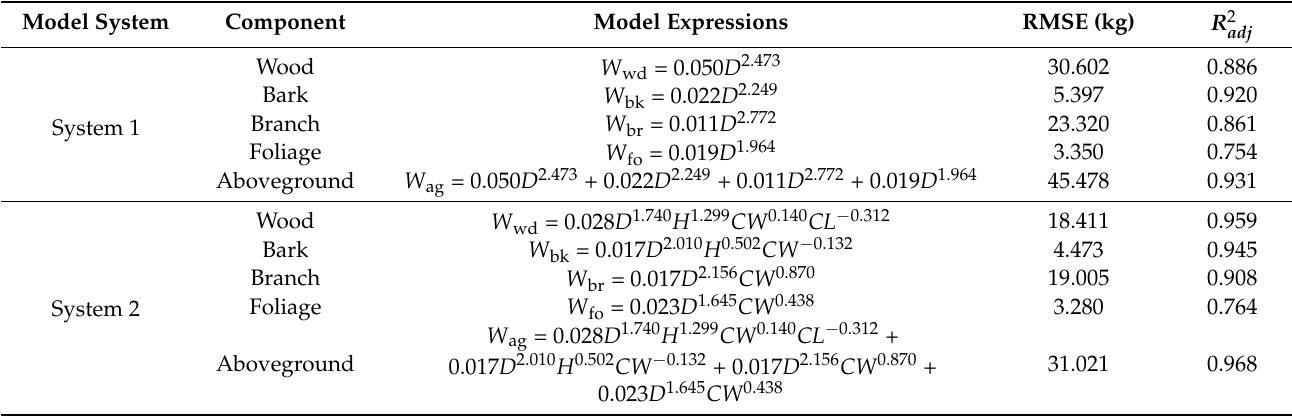
Table 4. Aboveground additive systems of the biomass models based on D and the selected predictors.